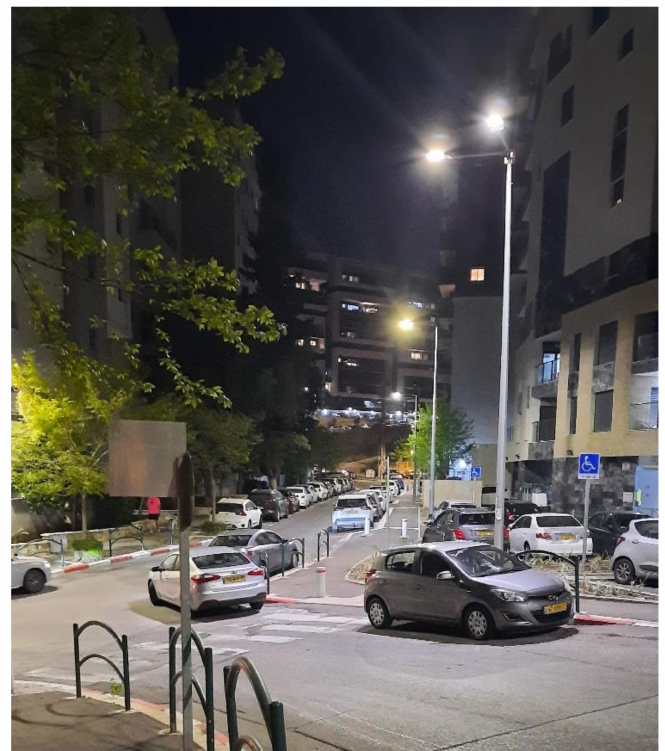
Figure 12. Night parking shortage, Haviva